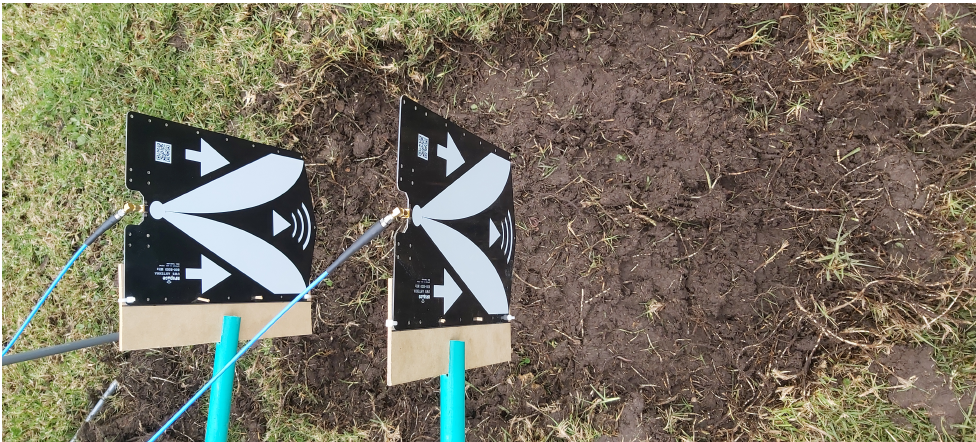
Figure 8. Buried objects experimental setup, soil